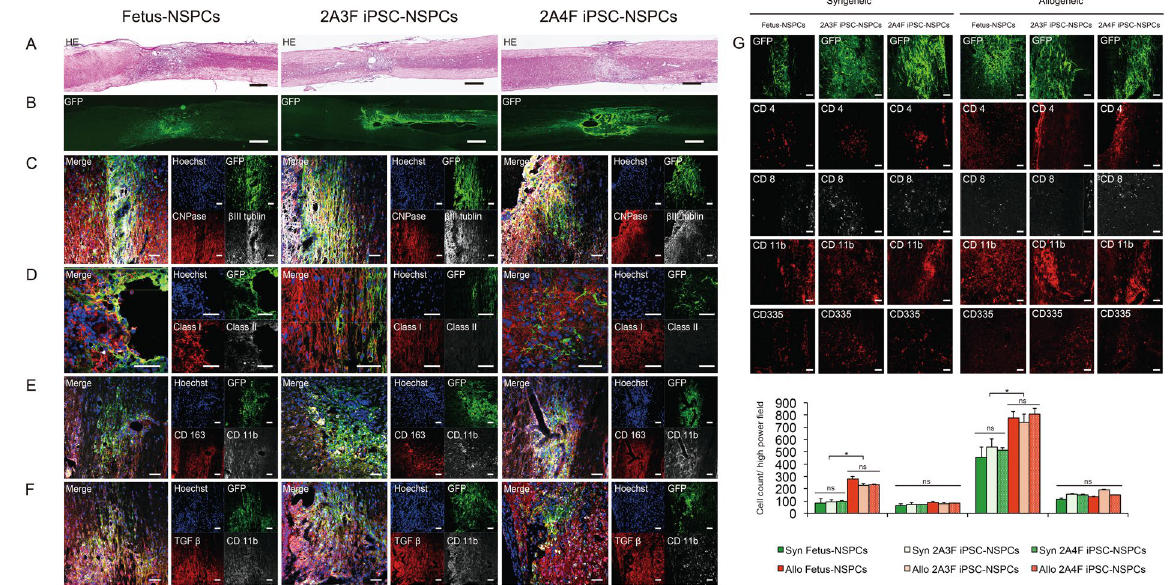
Figure 5. Histological examination of grafted syngeneic and MHC-mismatched allogeneic mice spinal cords. Fetus-NSPCs and iPSC-NSPCs (2A3F and 2A4F) transplanted into allogeneic hosts were stained with hematoxylin-eosin ( A ) and immunostained with antibodies against GFP, β III tubulin, CNPase, MHC class I, MHC class II, CD163, TGF β and Hoechst ( B – F ). All cell populations differentiated into three neural lineages. MHC expression was observed in a very small proportion of these cells after transplantation. Inflammatory cell infiltration was more obvious in allogeneic transplantation than syngeneic transplantation. Many of the infiltrating CD11b + macrophages were positive for CD163 and TGF β . ( G ) GFP, CD4, CD8, CD11b, and CD335 staining and quantified of inflammatory cells in mice with surviving syngeneic or allogeneic grafts. CD4 + and CD11 + cells infiltrated the allogeneic host spinal cord significantly more than syngeneic host spinal cord. Values are shown as the mean ± SEM. * P < 0.05, unpaired two-tailed Student’s t-test and one-way ANOVA followed by the Tukey–Kramer test. ns, not significant. Scale bars = 500 µ m in ( A ) and ( B ) and 100 µ m in ( C – G